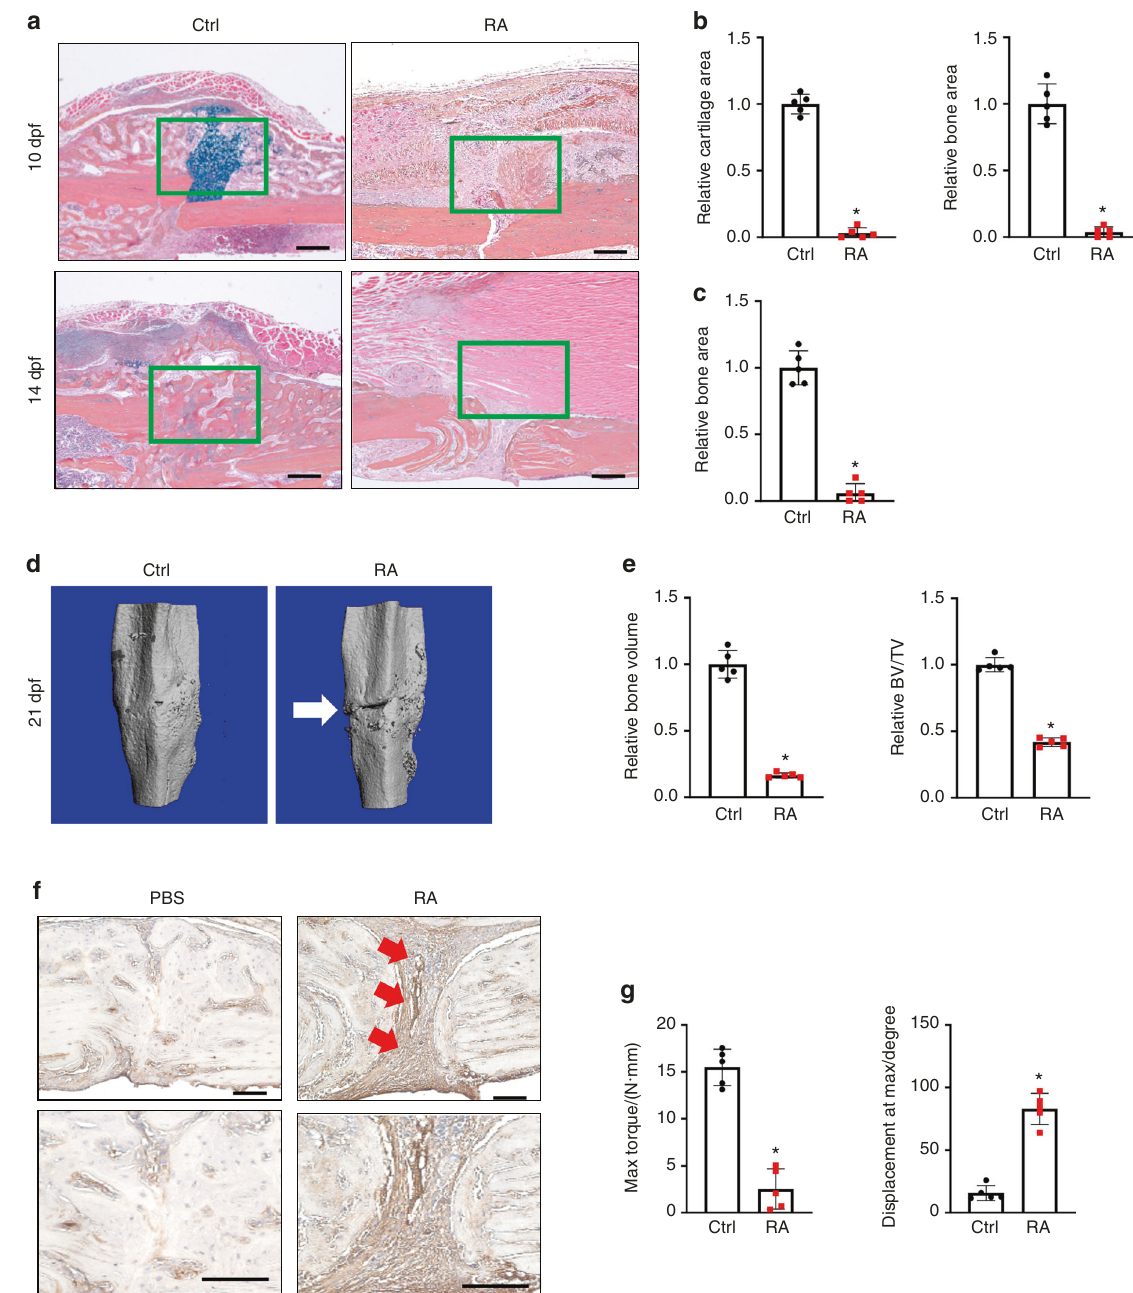
Fig. 1 Systemic in fl ammation-induced fracture nonunion in RA mice. a Representative ABH/OG staining of fracture callus sections from control and RA mice at 10 and 14 dpf ( n = 5). Histomorphometric quanti fi cation of cartilage and bone area was performed on ( b ) 10 dpf and ( c ) 14 dpf fracture callus sections from the control and RA mice ( n = 5). The results were normalized to the controls. * P < 0.05 compared with control by Student ’ s t test. d MicroCT assessment of mineralized bone within the fracture callus at 21 dpf from the control and RA mice ( n = 5). e Quanti fi cation of bony callus volume and relative BV/TV ratio based on microCT assessment of 21 dpf control and RA fracture calluses. All results were normalized to controls. * P < 0.05 compared with control by Student ’ s t test. f Immunohistochemical staining of 21 dpf fracture calluses from control and RA mice for COL3A1. g Biomechanical torsion testing of the control and RA fractures at 28 dpf ( n = 5). Max torque and displacement at max were quanti fi ed. All results were normalized to the controls. * P < 0.05 compared with control by Student ’ s t-